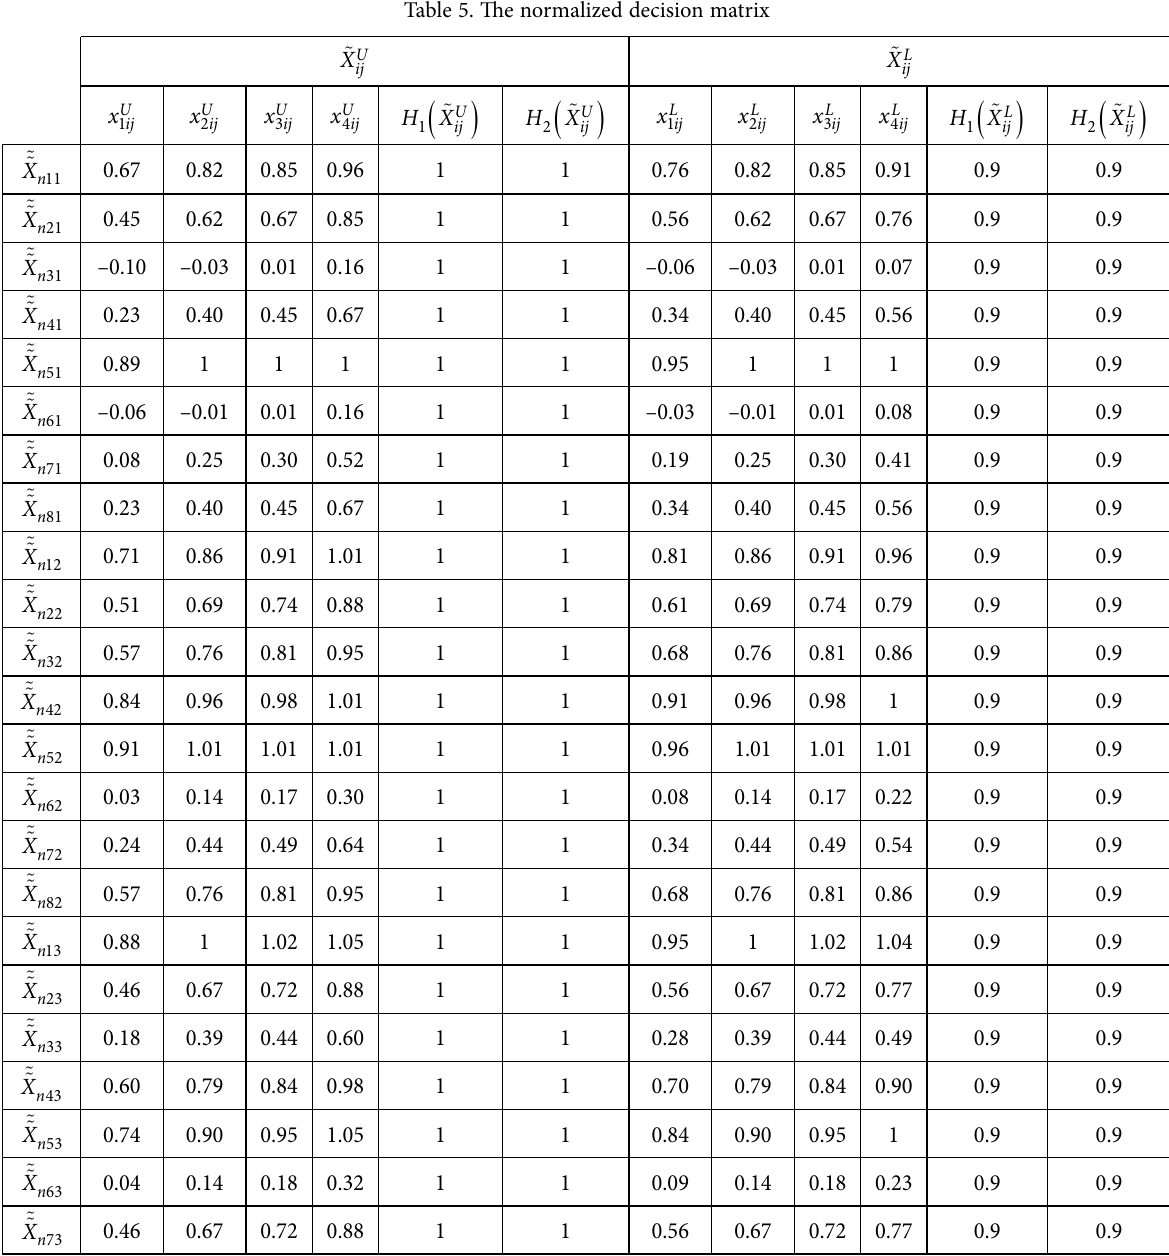
Table 5. The normalized decision matrix